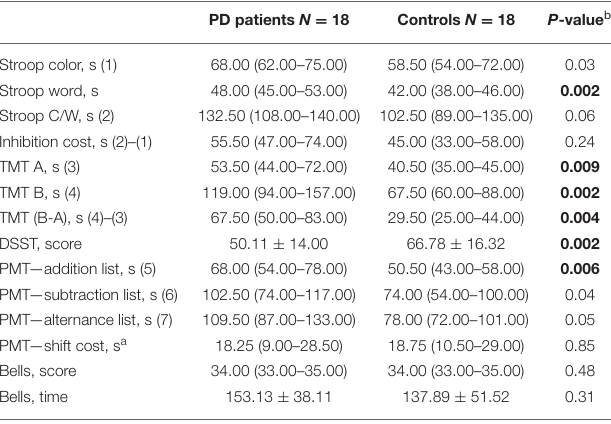
TABLE 3 | Comparison of performance on neuropsychological tests between PD patients and controls.